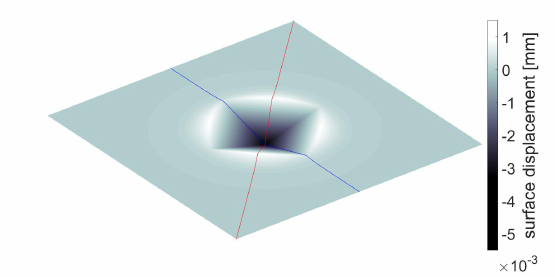
Figure 6. Surface profile cross-sections; Face profile (red), diagonal profile